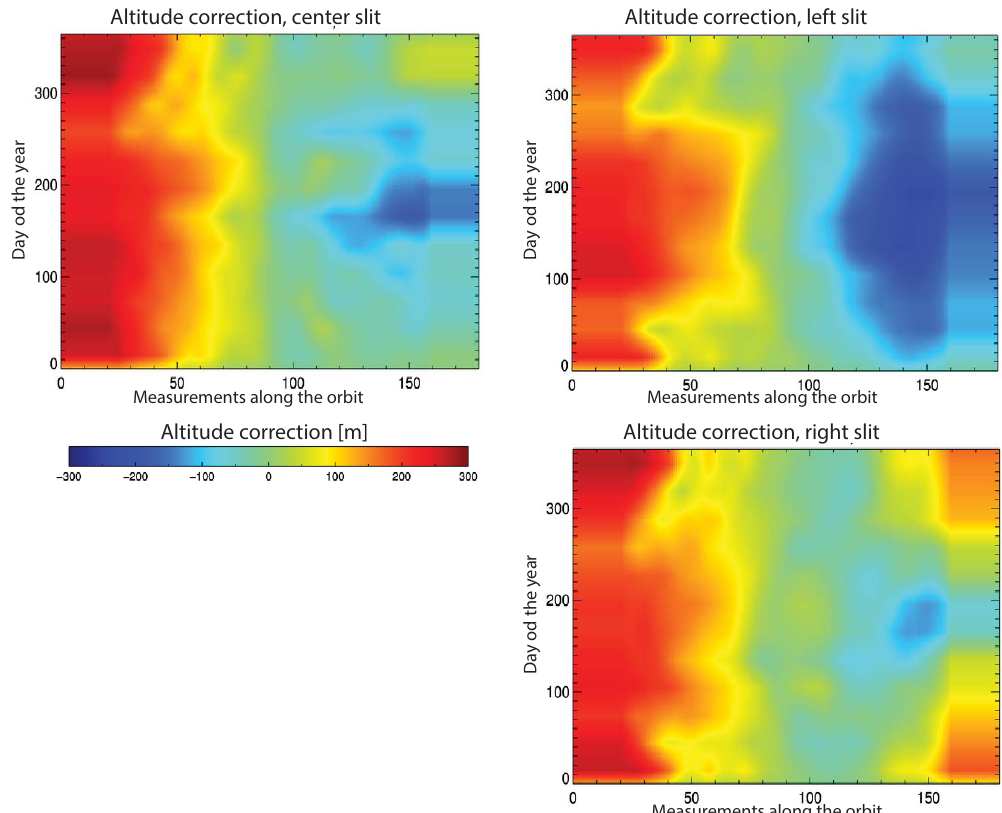
Figure 1. Intra-orbital and seasonally varying corrections in the OMPS LP altitude registration derived from the ARRM (see text for the details) for each LP slit. The corrections are expressed in meters and shown as functions of event number along the orbit ( x axis) and day of the year ( y axis). Event number along the orbit does not directly correspond to a specific latitude, because OMPS LP acquires solar-scattered measurements and the latitude where LP makes its first measurement on orbit varies seasonally with the solar zenith angle. Our analysis of measured radiances strongly suggests that the altitude registration error depends on the event number (or the time that the instrument is exposed to solar light) rather than the geographic